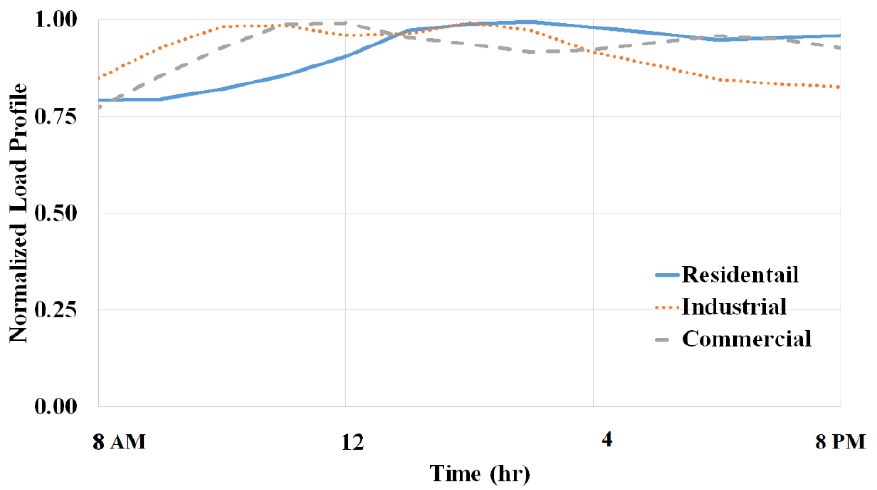
Figure 6. Normalized load profiles of a substation located in Riyadh city.